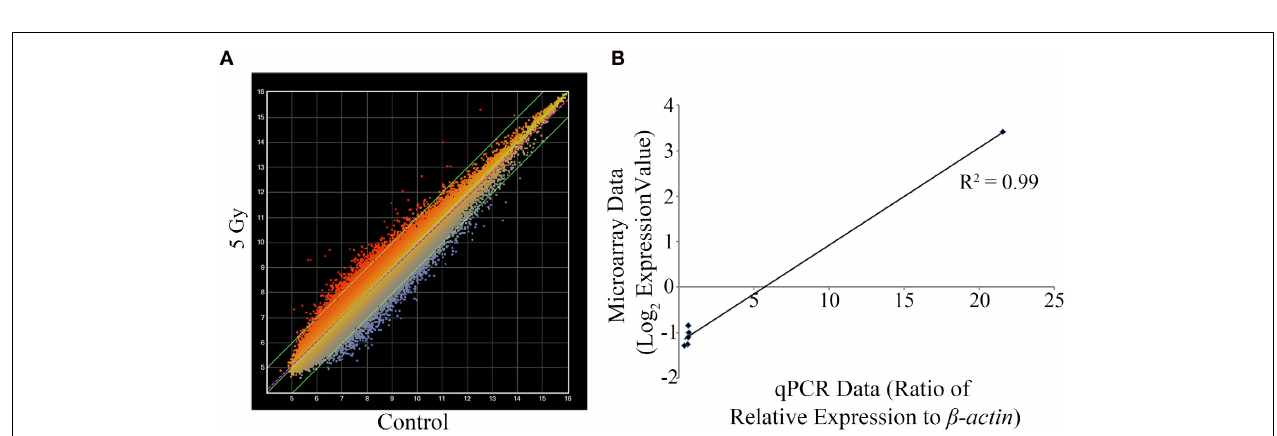
FIGURE 1 | Gross morphological measurements at 120hpf. Malformations and gross morphological measurements were assessed at 120hpf in the control (A) , 1 Gy (B) , 2 Gy (C) , 5 Gy (D) , and 10 Gy (E)